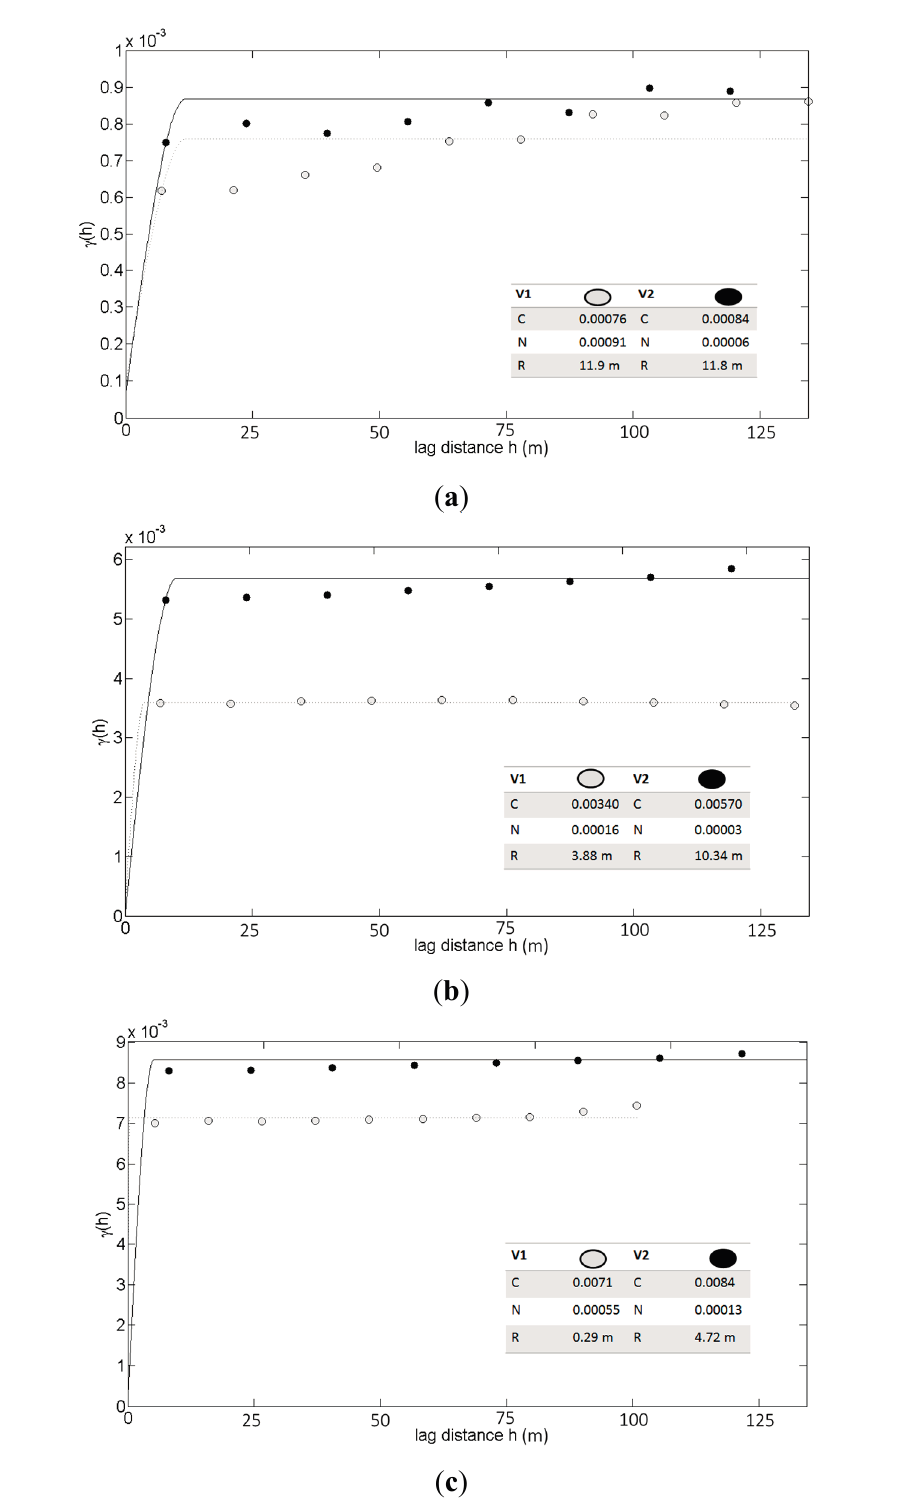
Figure 5. NDVI v ariograms of three platforms at native resolutions. The lines represent the fitted variograms models. The parameter of the variogram model are reported in the legend: C = sill, N = nugget, and R = range. ( a ) Satellite, ( b ) Aircraft, and ( c )